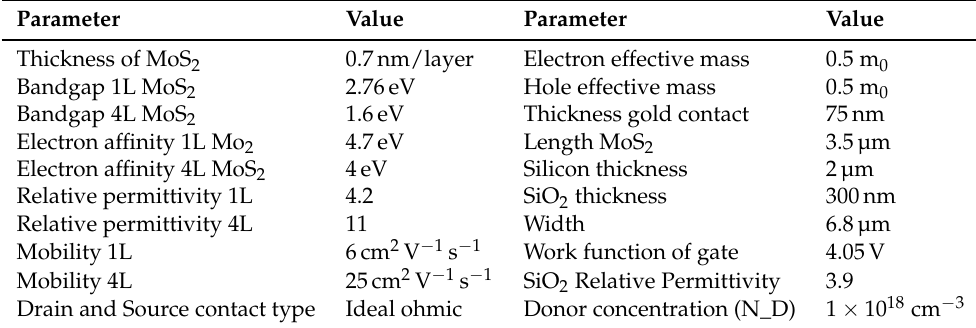
Table 1. Simulation parameters. Material properties are from the supporting information provided in attachment to [28].